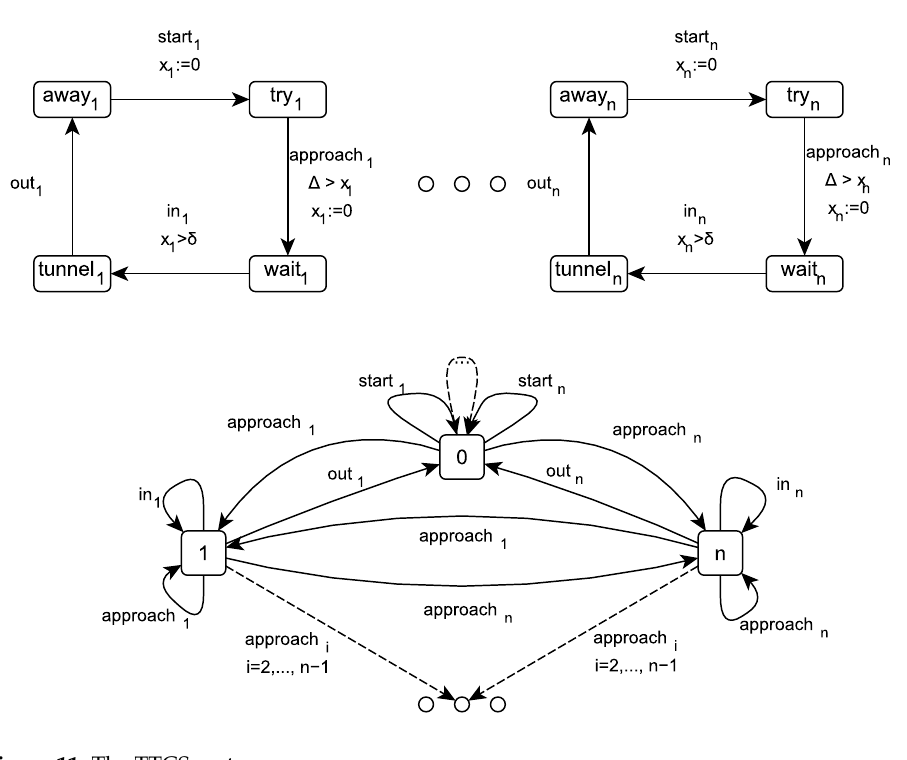
Figure 11. The TTCS system.